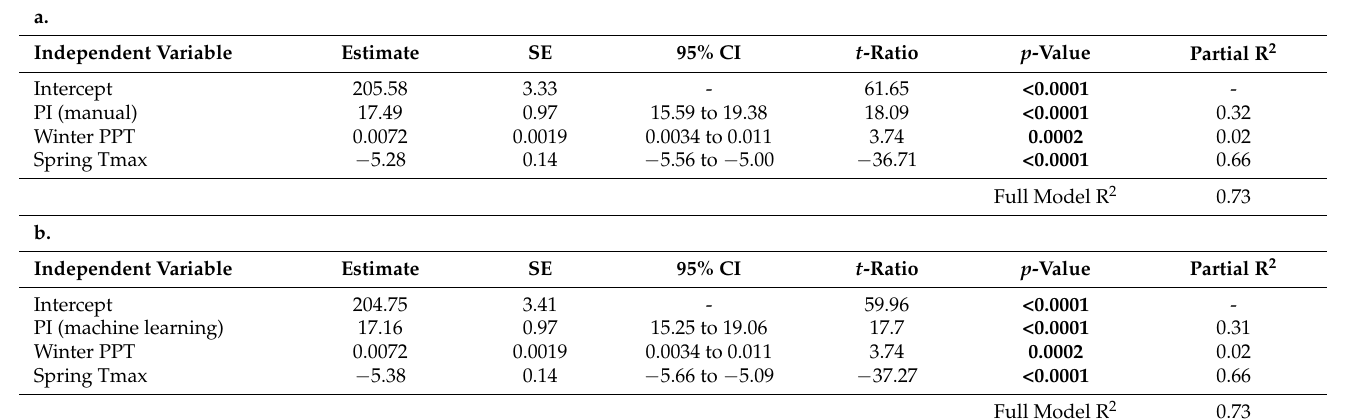
Table 4. Summary of the multiple linear regressions designed to estimate the sensitivity of flowering date to climate during the year of specimen collection while controlling for the phenological status as estimated by the (a) manually-derived or (b) machine-learning-derived phenological index (PI). Bold values represent significant effects at p <